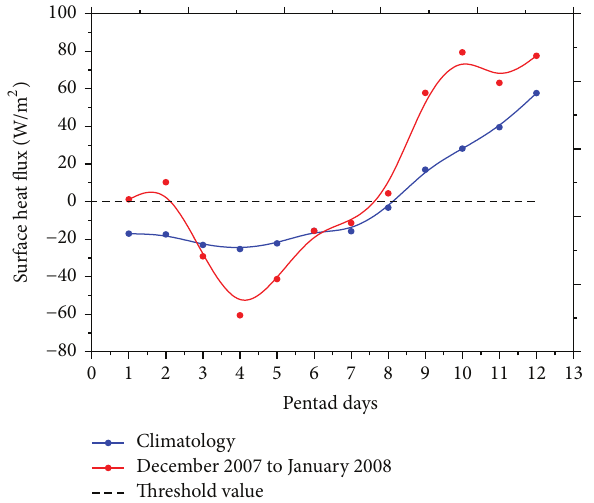
Figure 2: Time series of pentad accumulation of surface heat flux in